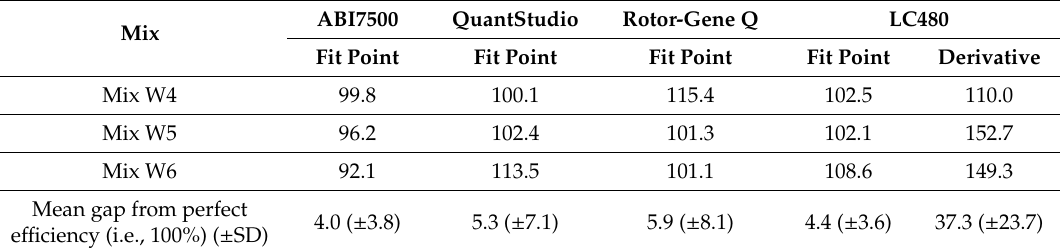
Table 2. RT-qPCR e ffi ciency (%) according to platform and master mixes. (Mix 4) Superscript III